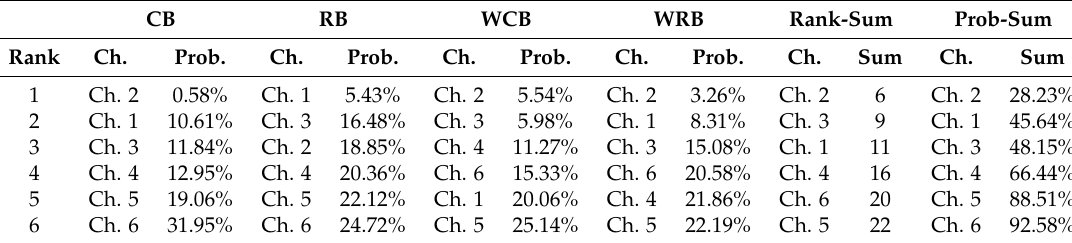
Table 4. Calculated occupancy probability and channel